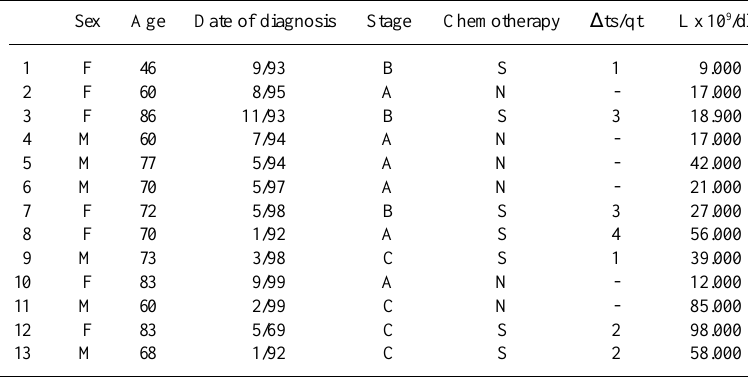
Table I - Patient diagnostic